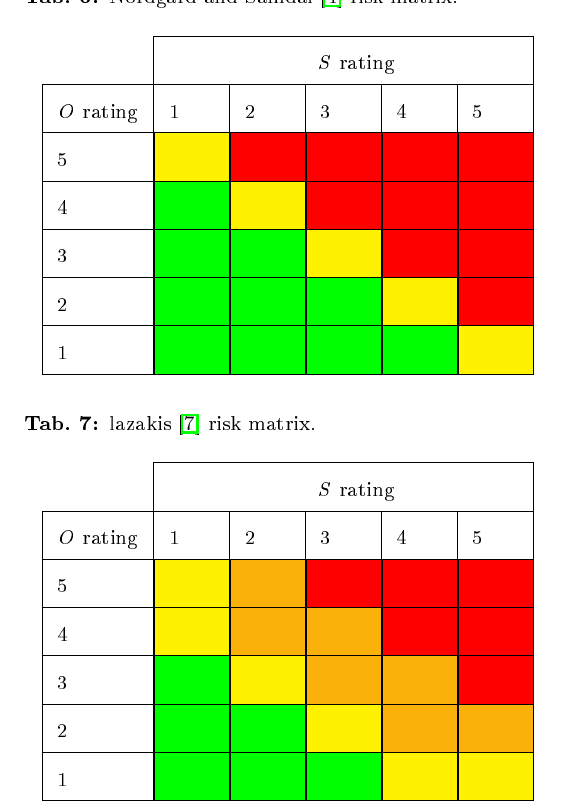
Tab. 6: Nordgard and Samdal [4] risk matrix.